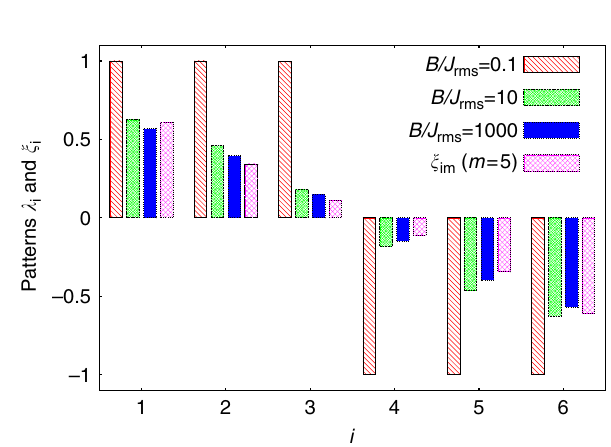
Figure 7 | From binary to real-valued patterns. The spin expectation values l i approach the real values of the mode vector x im when a sufficiently strong transverse magnetic field B is present. The shown data was obtained from the effective spin Hamiltonian for N ¼ 6 ions in the ferromagnetic regime, d ¼ 2 p (cid:2) 143kHz. Deviations from the equality l i ¼ x im are smaller than